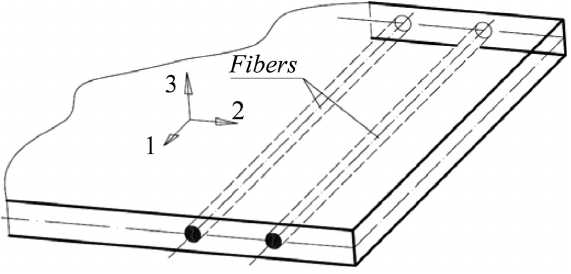
Fig. 2. Principal material directions for an individual layer; 1 is a direction of the fi